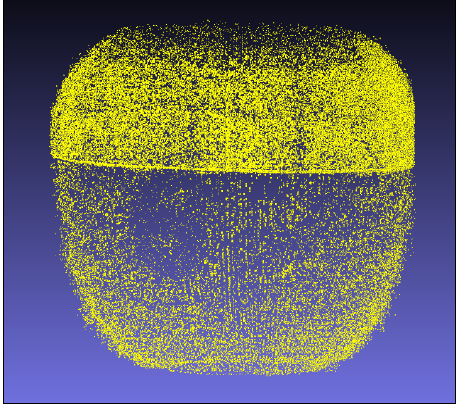
Fig. 9. Cloud Points for Dome Case Study.